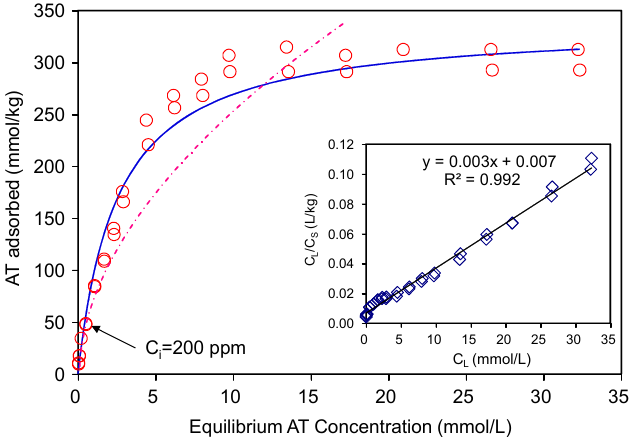
Figure 3. Adsorption of atenolol on SAz-2 at pH10. The dashed line is the Freundlich model fitting, the solid line is the Langmuir model fitting, which align to the observed data.